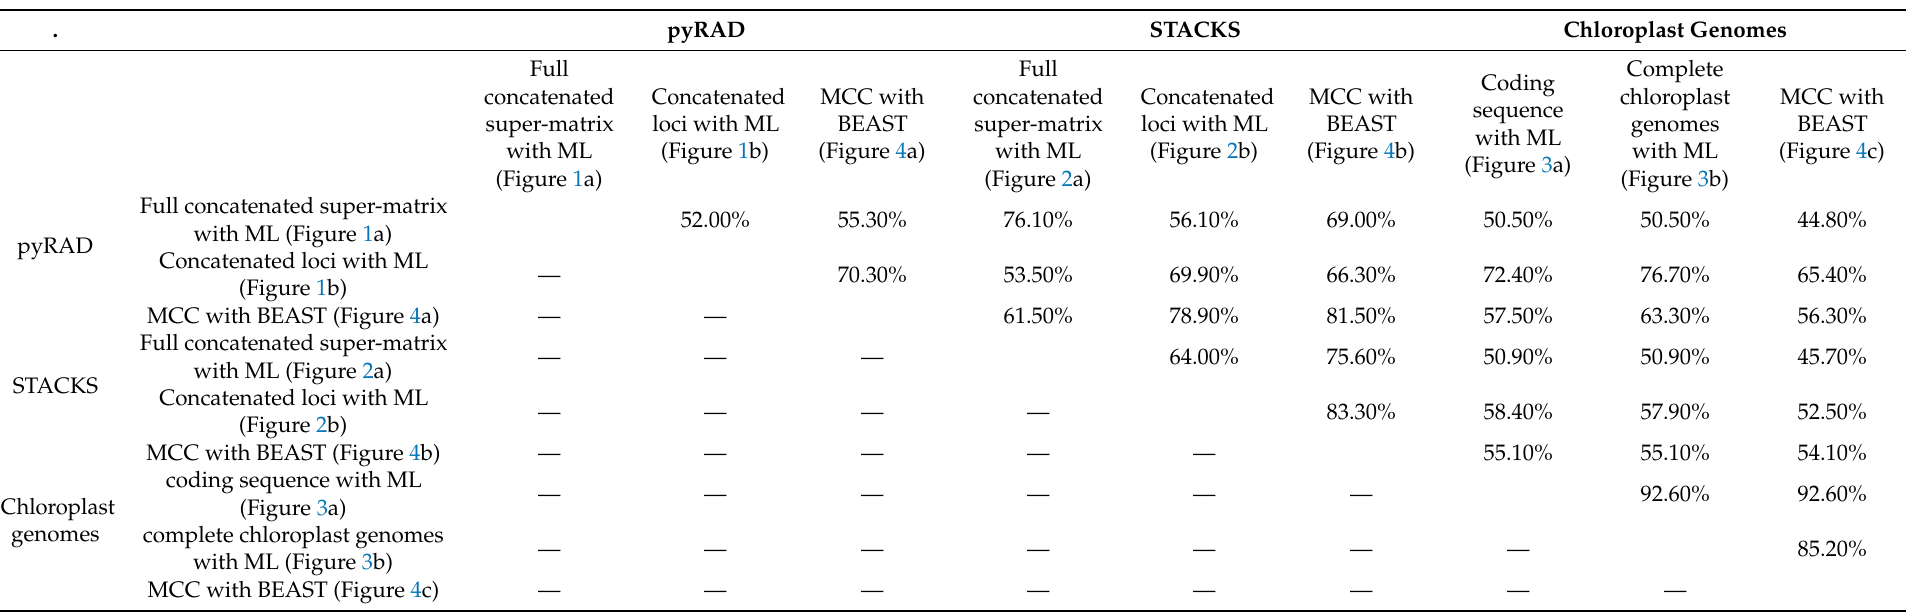
Table 2. Topological scores (%) calculated using Compare 2 Trees, showing the similarity between tree topologies with the corresponding figure numbers.